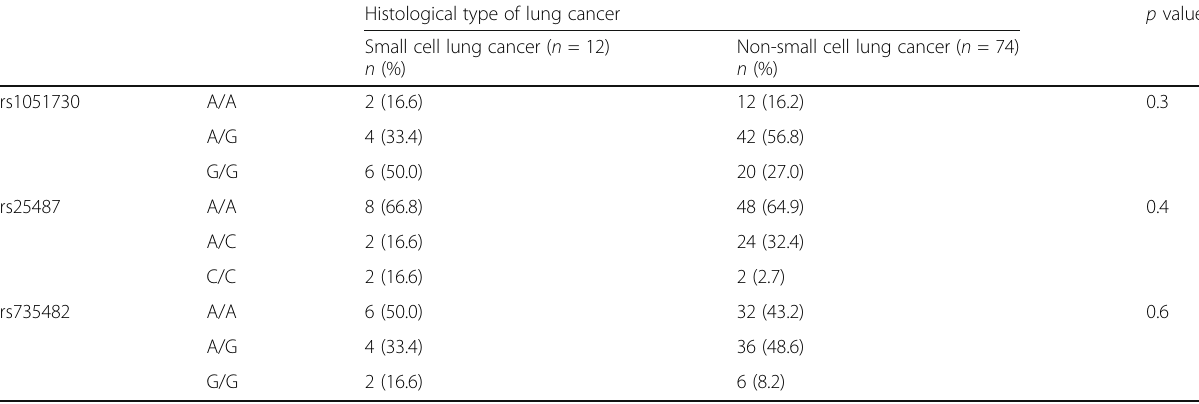
Table 4 Genotypes frequency in different histological types of lung cancer Histological type of lung cancer p